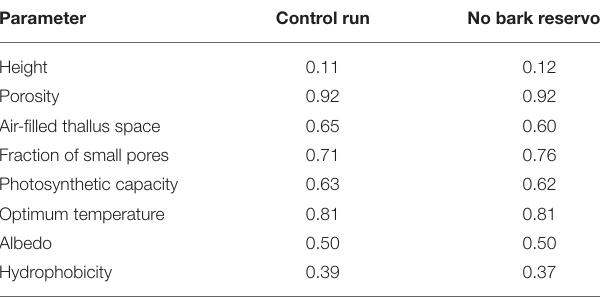
TABLE 2 | Physiological parameters used in the LiBry model to define a physiological